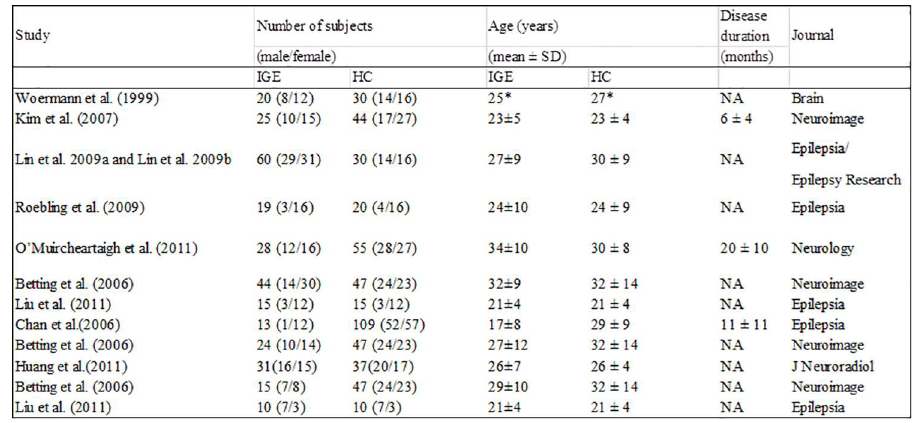
deviation; NA, not available; * Medianage.